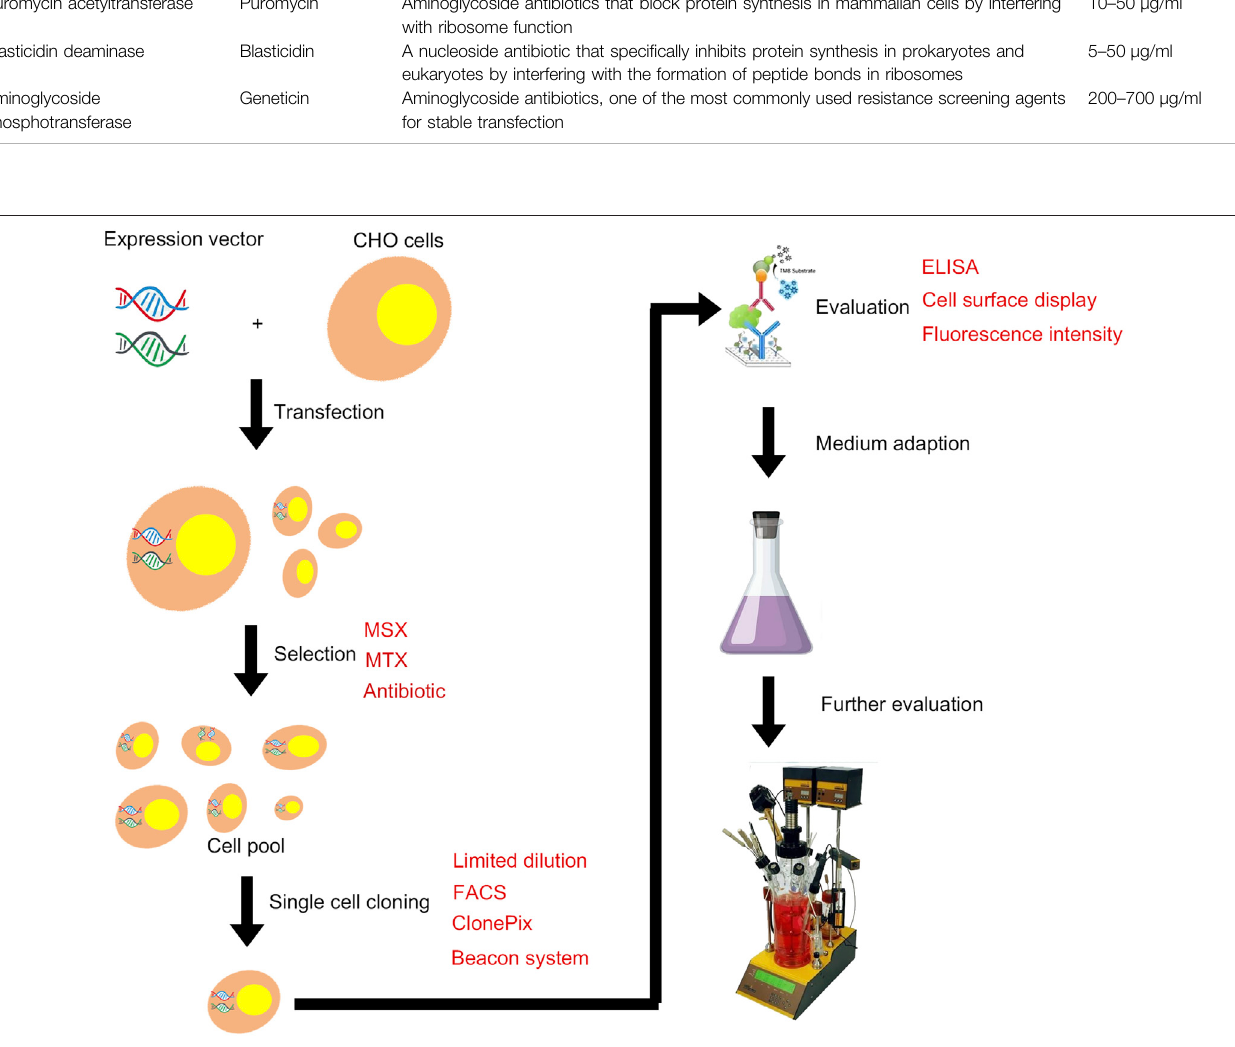
Frontiers in Bioengineering and Biotechnology |